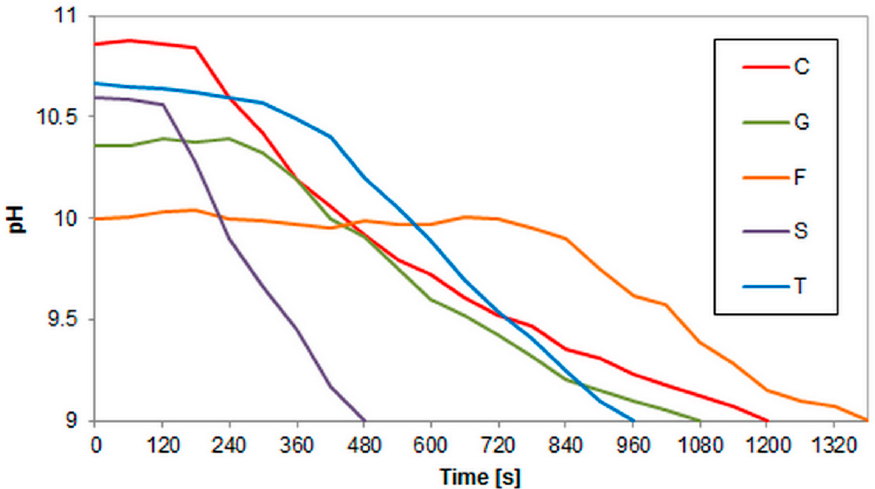
Figure 1. Evolution of the pH in the reaction mixture without additives ( C ), with addition of glucose ( G ), fructose ( F ), sucrose ( S ), and trehalose ( T